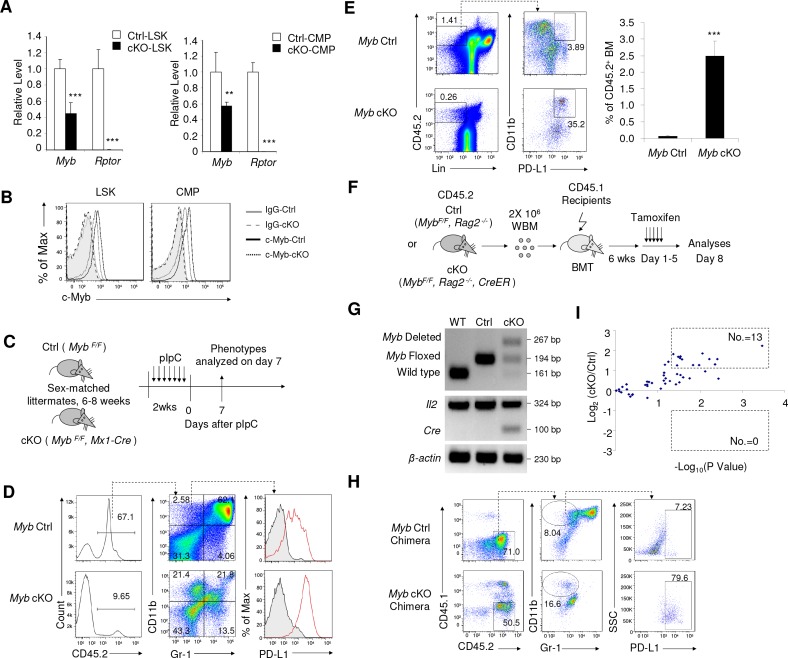
Inactivation of Myb is an underlying cause for accumulation of IMLEC.(A) Reduction of Myb mRNA in the Rptor-deficient HSPCs. BM LSK and CMP populations were FACS-sorted from Ctrl and cKO mice at 1–3 weeks after pIpC treatment. Quantitation of Myb mRNA was performed by qPCR. n = 5 for Ctrl-LSK; n = 4 for cKO-LSK (left). n = 4 for Ctrl-CMP; n = 3 for cKO-CMP (right). (B) Detection of c-Myb protein by intracellular staining. Data represent one of three independent experiments with similar results. (C–E) Deletion of c-Myb in mice with homozygous floxed Myb resulted in enhanced generation of IMLECs. (C) Schematic of experimental design. Sex-matched 6–8 weeks old c-Myb Ctrl (Myb F/F) and cKO (Myb F/F, Mx1-Cre) mice were treated with pIpC for seven times. The phenotypes were analyzed on day seven after the complement of pIpC treatment. Inducible deletion of c-Myb showed obvious increase of PD-L1 expression on CD11b+Gr-1- BM cells (D) and production of IMLECs (E). n = 3 for c-Myb Ctrl mice; n = 3 for c-Myb cKO mice. (F–H) Deletion of Myb enhances generation of IMLEC. (F) Diagram of experimental design. Whole BM cells (2 × 106/mice) of given genotypes were used for transplantation. Once the chimera mice were established, deletion of Myb was induced by five daily injection of tamoxifen. (G) Detection of Myb deletion in the whole BM cells after tamoxifen treatments. Data are representative of two independent experiments. (H) Generation of IMLEC is promoted by inactivation of Myb. BM cells were harvested at 7 days after first tamoxifen treatment and analyzed for IMLECs based on surface markers CD11b, Gr-1 and PD-L1 within the donor-derived CD45.2+ BM cells. Data shown represent one of three experiments using either first or second generation of BM chimeras. (I) Rptor deletion broadly increases miRNAs targeting Myb. Lin- c-Kit+ HSPCs were isolated from Raptor Ctrl and cKO mice at 10 days after pIpC treatment. miRNA levels were measured by miRNA microarray. The y-axis shows the log2 ratio of signal, while the x-axis shows the -log10P value. The doted boxes show the numbers of significantly (p<0.05) up-regulated (fold change >2) or down-regulated (fold change <0.5) miRNAs among 50 miRNAs with mirSVR score <−1.0. Each dot represents the mean value of a unique miRNA from three independent samples.